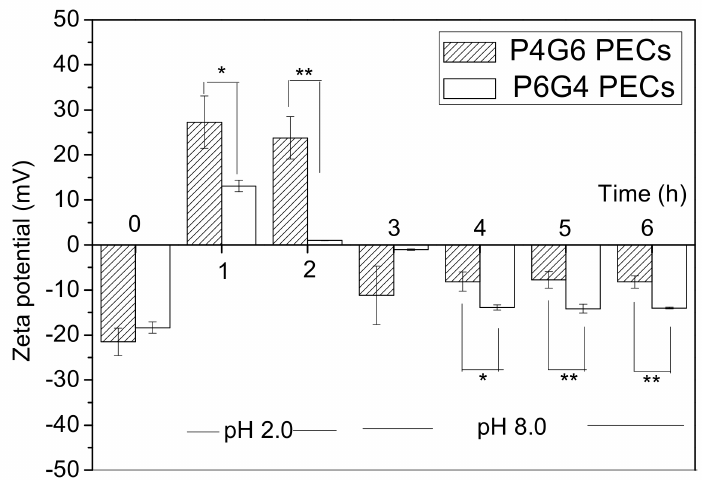
Figure 3. Zeta potentials of the PECs. P4G6 and P6G4 PECs were placed at 37 ◦ C and pH 2.0 for 2 h, and the environmental pH was adjusted to 8.0 for 4 h to simulate drug transportation in the GI tract. At the predetermined time points (each hour), zeta potential was determined by electrophoretic light scattering (ELS). The results have been statistically analyzed using Student’s t -test (Microsoft Excel 2000). Differences were recognized as statistically significant when the p values were less than 0.05, and significant differences are shown in star marks (* p < 0.05 and ** p <